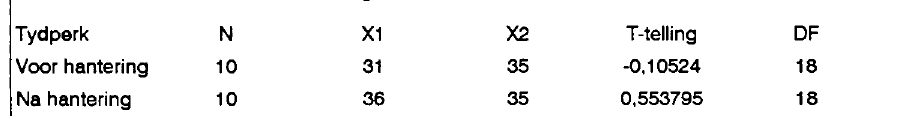
Tabel 5: Resultate van die gemiddelde diastoliese bloeddruk van die babas